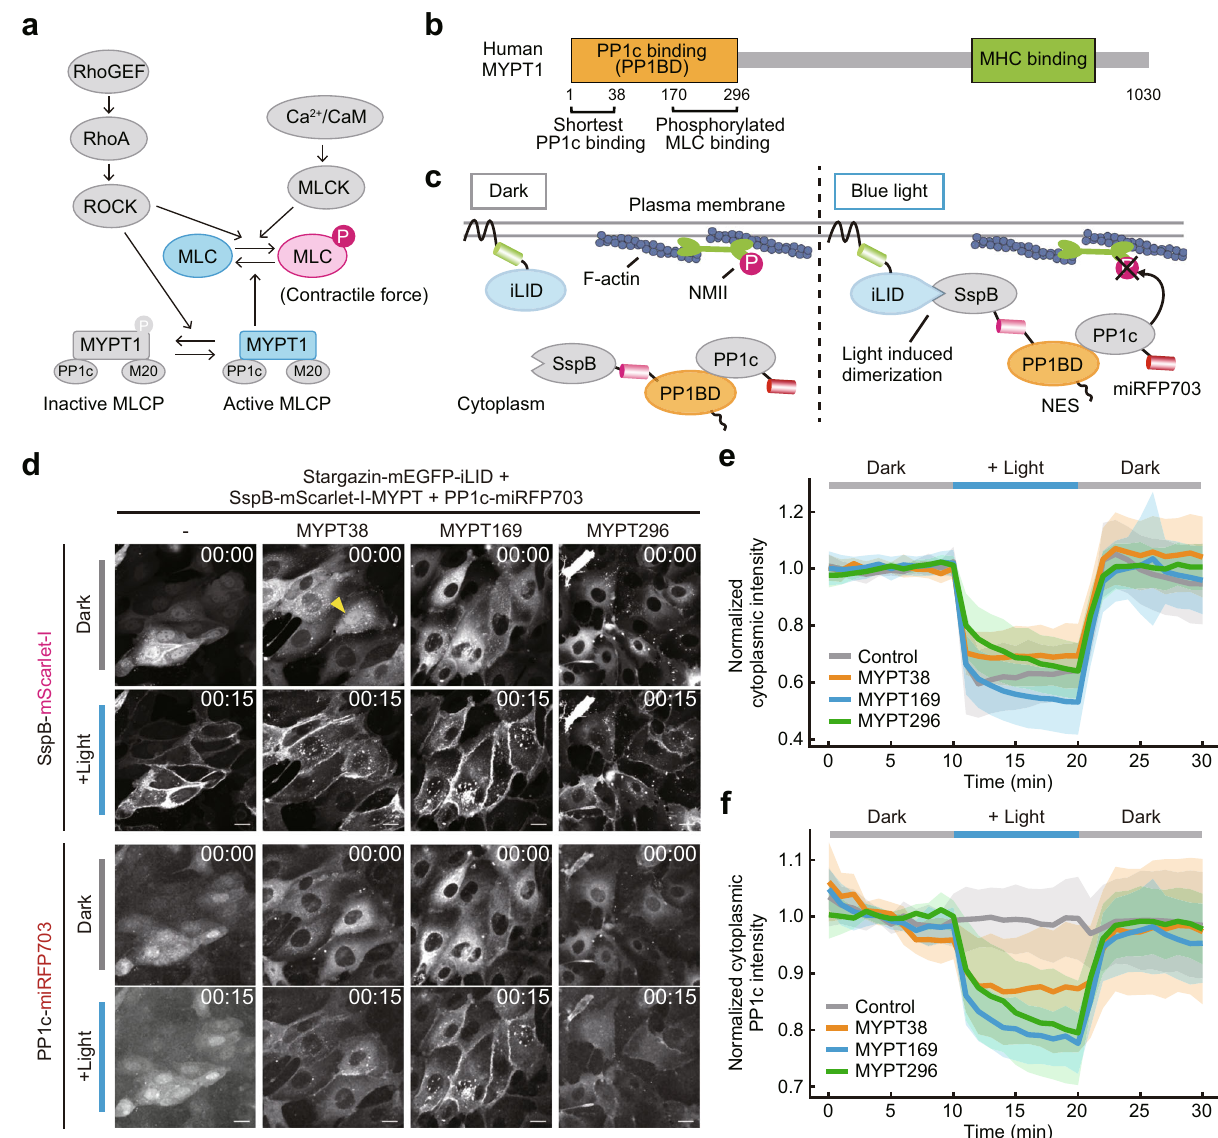
Fig. 1 Development of the OptoMYPT system. a Schematic illustration of the signaling pathway for the regulation of MLC phosphorylation. b Domain structure of human MYPT1. c Schematic illustration of the OptoMYPT system. Stargazin-mEGFP-iLID is anchored to the plasma membrane. Upon blue light illumination, the SspB-mScarlet-I-fused PP1c-binding domain (PP1BD) of MYPT1 translocates to the plasma membrane along with endogenous PP1c, and inactivates NMII at the cell cortex. d Representative images of the SspB-mScarlet-I or the indicated SspB-mScarlet-I-PP1BDs of MYPT1 (upper two rows) and simultaneously expressing PP1c-miRFP703 (lower two rows) in MDCK cells under the dark condition (the fi rst and third rows) and blue light condition (the second and fourth rows). Stargazin-mEGFP-iLID was also expressed as a localizer in all experiments. The yellow arrowhead indicates a cell showing nuclear accumulation of SspB-mScarlet-I-MYPT38. Blue light was continuously illuminated from the top of the stage. Scale bar, 20 μ m. e Quanti fi cation of the cytoplasmic fl uorescence change in mScarlet-I in panel d . The average values (bold lines) are plotted as a function of time with the SD. n = 15 cells. f Quanti fi cation of the cytoplasmic fl uorescence change in PP1c-miRFP703 in the indicated MDCK cells. The average values (bold lines) are plotted as a function of time with the SD. n = 15 cells.